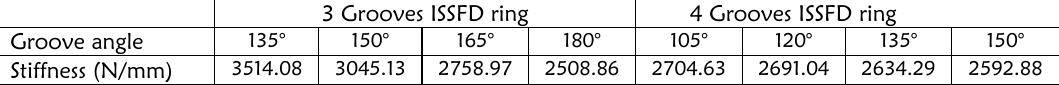
Table 2: Average stiffness values of 3 and 4 grooves ISSFD rings 3 Grooves ISSFD